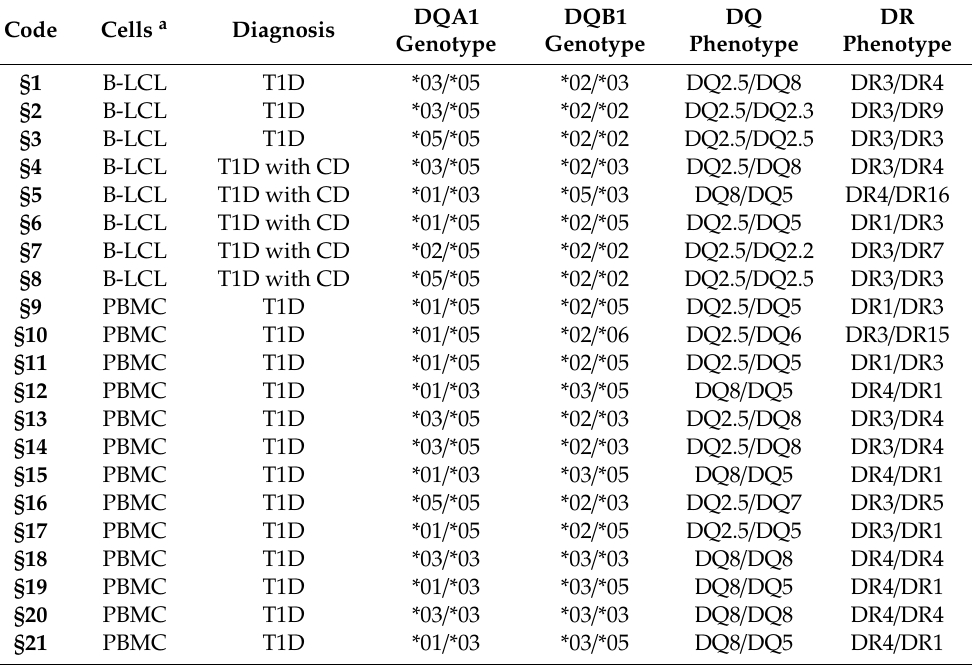
Table 1. HLA-DQ and HLA-DR genotype and phenotype of T1D patients enrolled in the